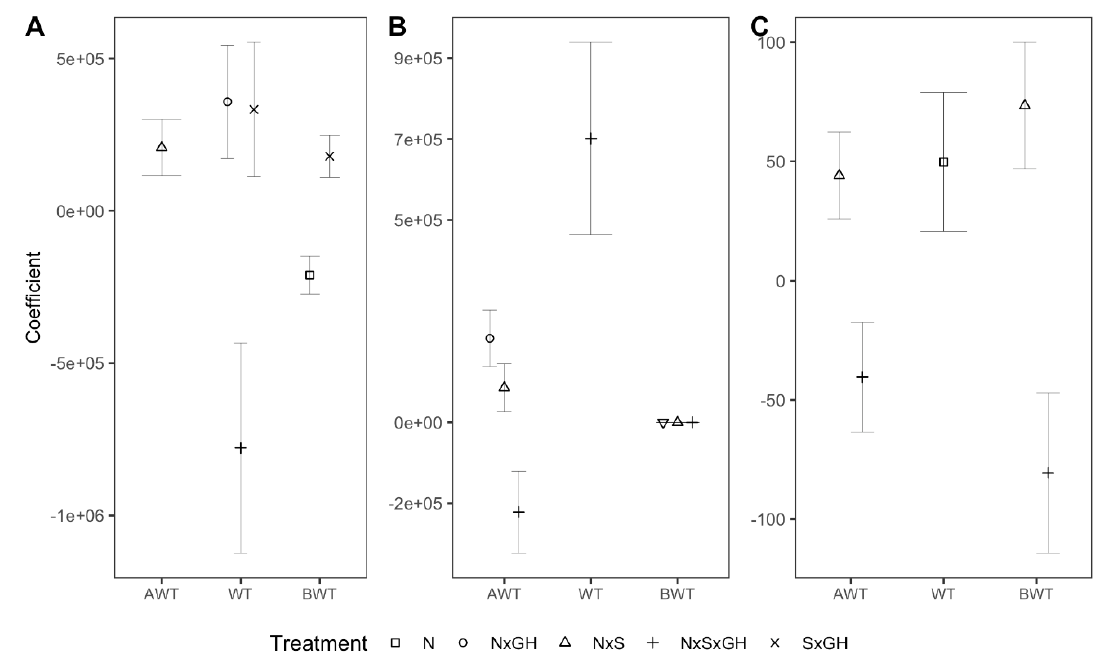
Figure 3. Multiple linear regression coefficients for (A) abundance of mcr A gene copies, (B) abundance of mcr A transcripts, and (C) transcript/gene quotient; in the peat profile above the mean annual water table level (AWT), around the mean annual water table level (WT) and below the mean annual water table level (BWT). Each treatment response is represented by the coefficient reflecting the change in mcr A abundance (relative to ambient conditions) in response to the ‘High’ treatments involving N (30 kg ha -1 yr -1 ) or S (20 kg ha -1 yr -1 ) amendment or warming (GH), singly and in combination. Error bars represent one standard error. For number of replicates, see Table A1 in the Appendix. The results are based on the MLR model ( Y = β + β N + β S + β GH + β (N×S) + β (N×GH) + β (S×GH) + β (N×S×GH) + ε ). Only the 0 1 2 3 4 5 6 7 significant coefficients are